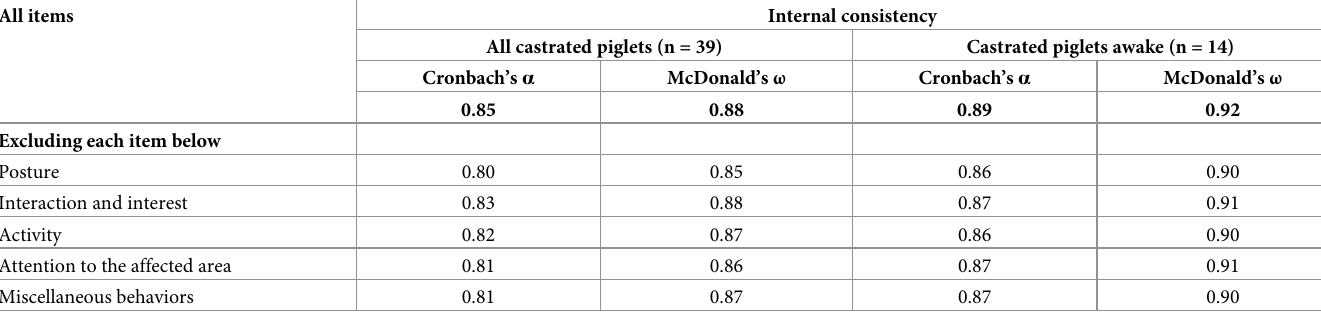
Table 10. Internal consistency of the UPAPS applied for castrated piglets awake (n = 14). All